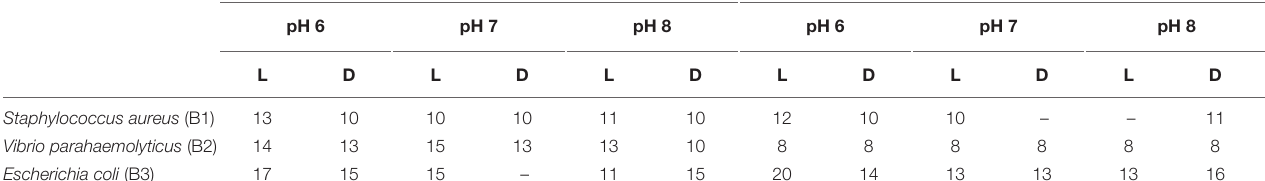
TABLE 4 | Antimicrobial activity of biosynthesized AgNPs combined with methanol extract of culture filtrate. Pathogens